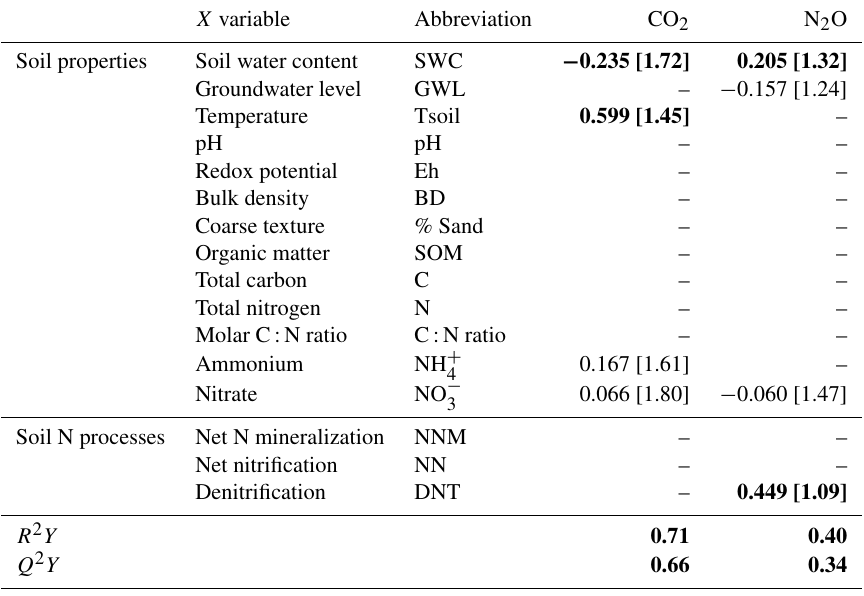
Table 4. Summary of the partial least squares (PLS) models produced for CO 2 and N 2 O emissions at the riparian site ( n = 75). Values are the coefficients from PLS models which describe the relationship (direction and relative strength) between explanatory variables and gas emissions. The variance inflation factor (VIF) of each explanatory variable, indicative of collinearity, is shown in brackets. Bold values indicate the most influencing variables (variable importance in the projection (VIP) > 1 .